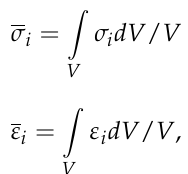
Figure 3. Boundary conditions and load application.